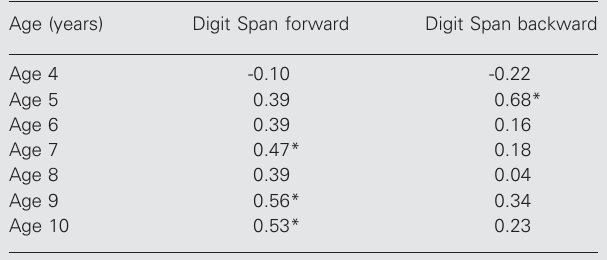
Table 5. Pearson correlations between BCPR and Digit Span by age.